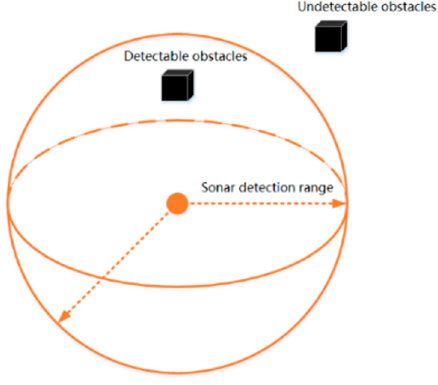
Figure 3. Schematic diagram of sonar work.